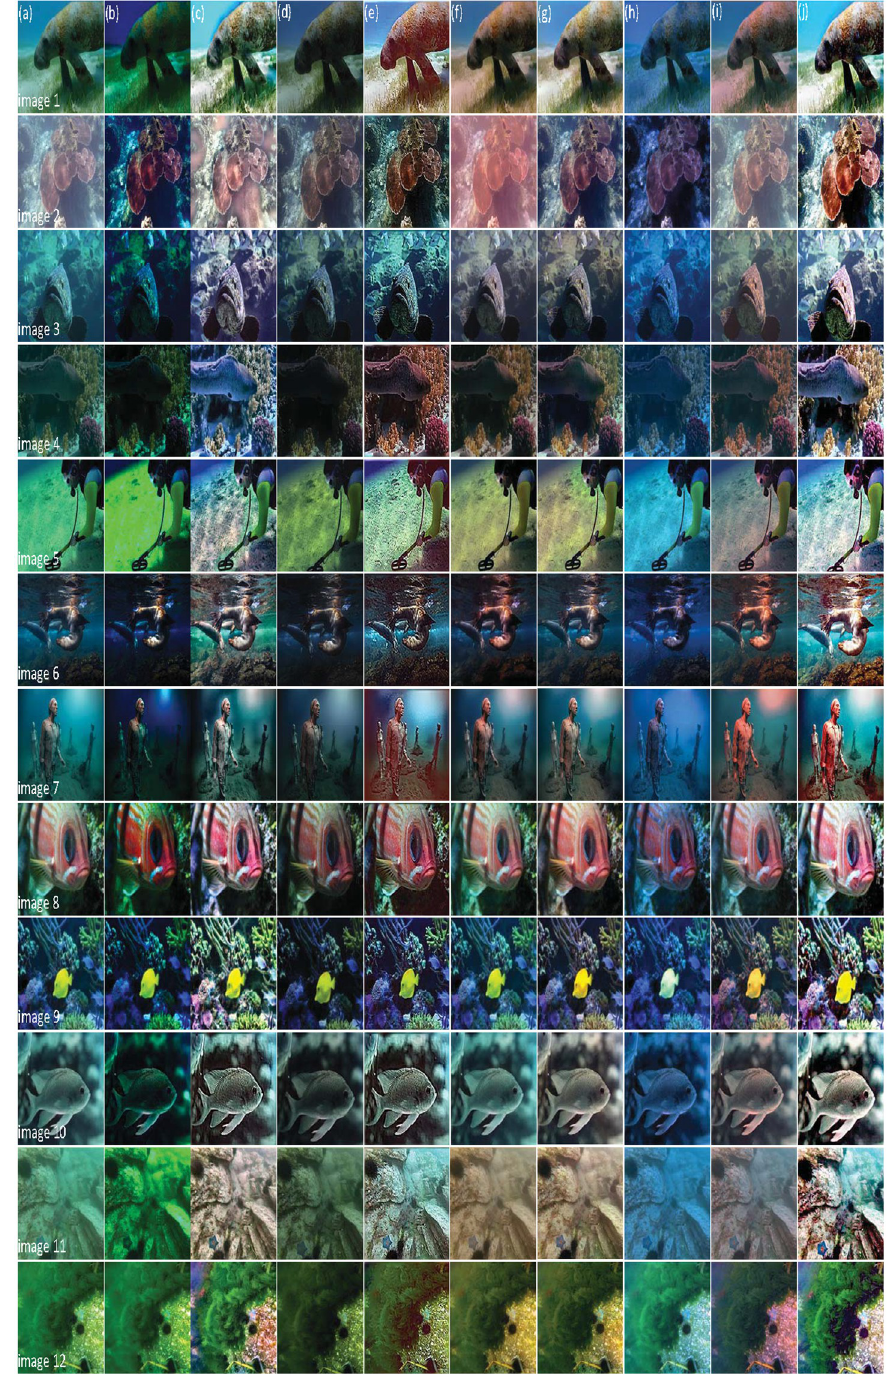
Fig 9. Experimental results in complex underwater environments. (a) Degraded image; (b) UDCP; (c) DRDCP; (d) Fusion; (e) UNTV; (f) MLFcGAN; (g) FUnIE-GAN; (h) UWCNN; (i) Water-Net; (j) Ours.